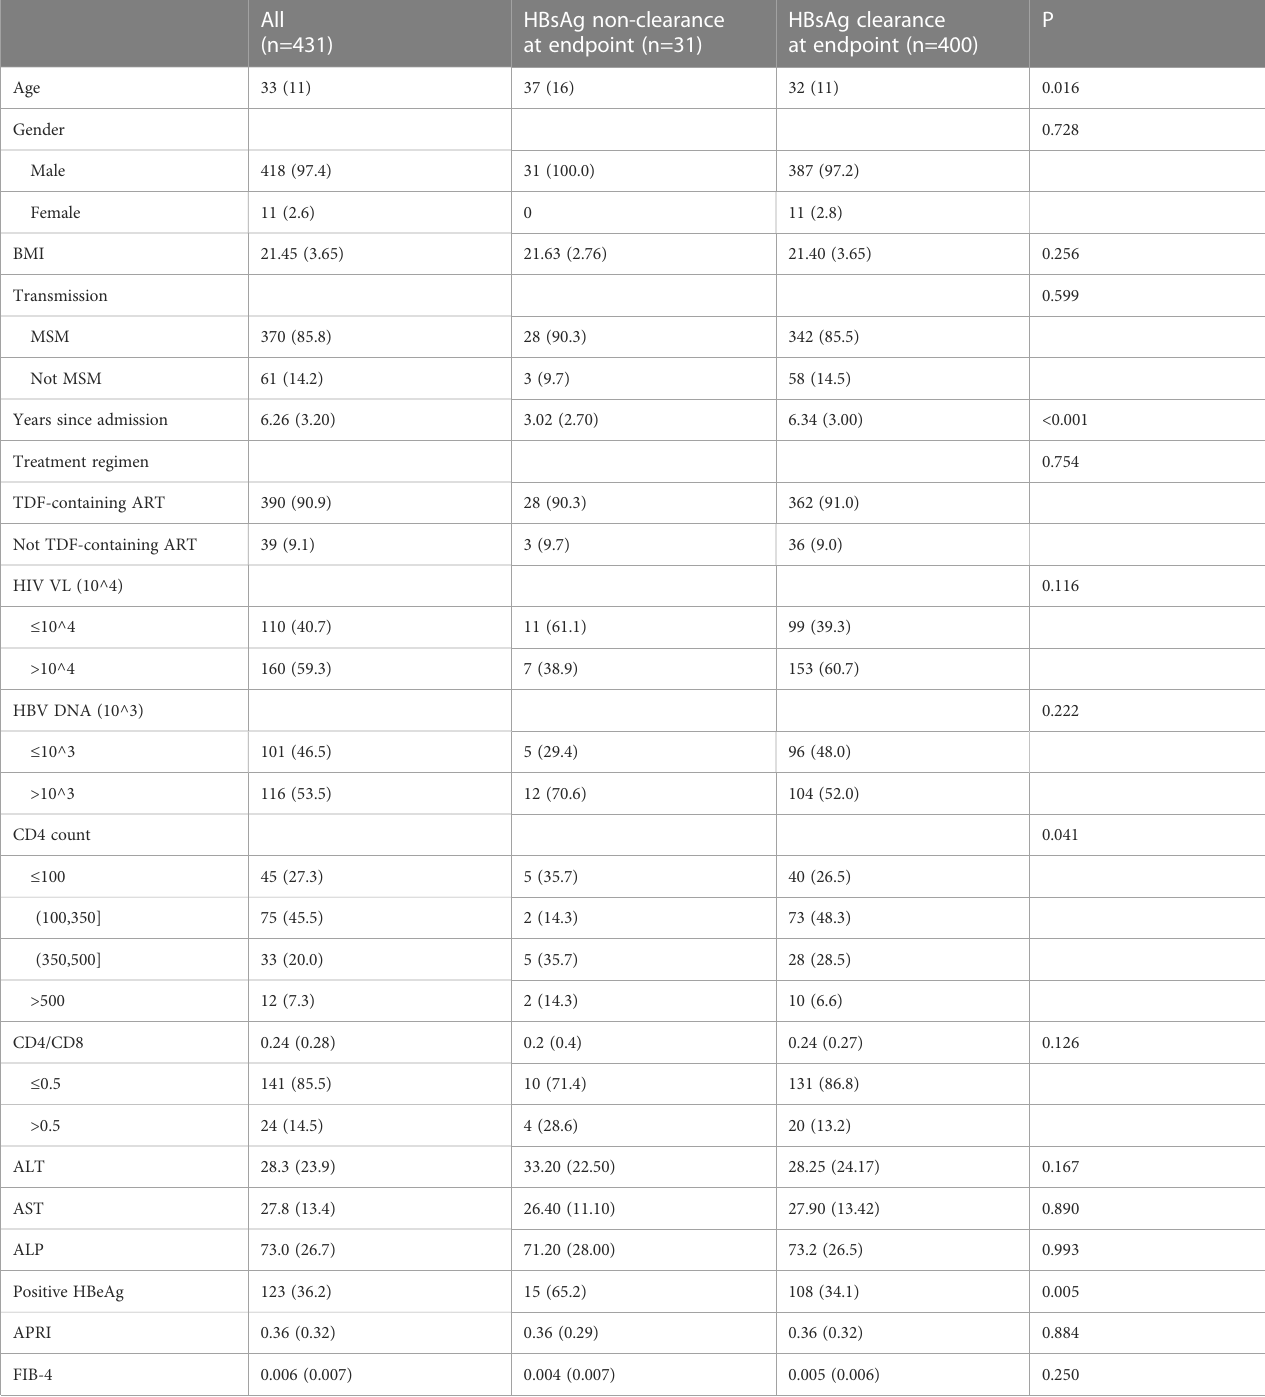
TABLE 1 Baseline clinical characteristics of 431 patients with HIV/HBV